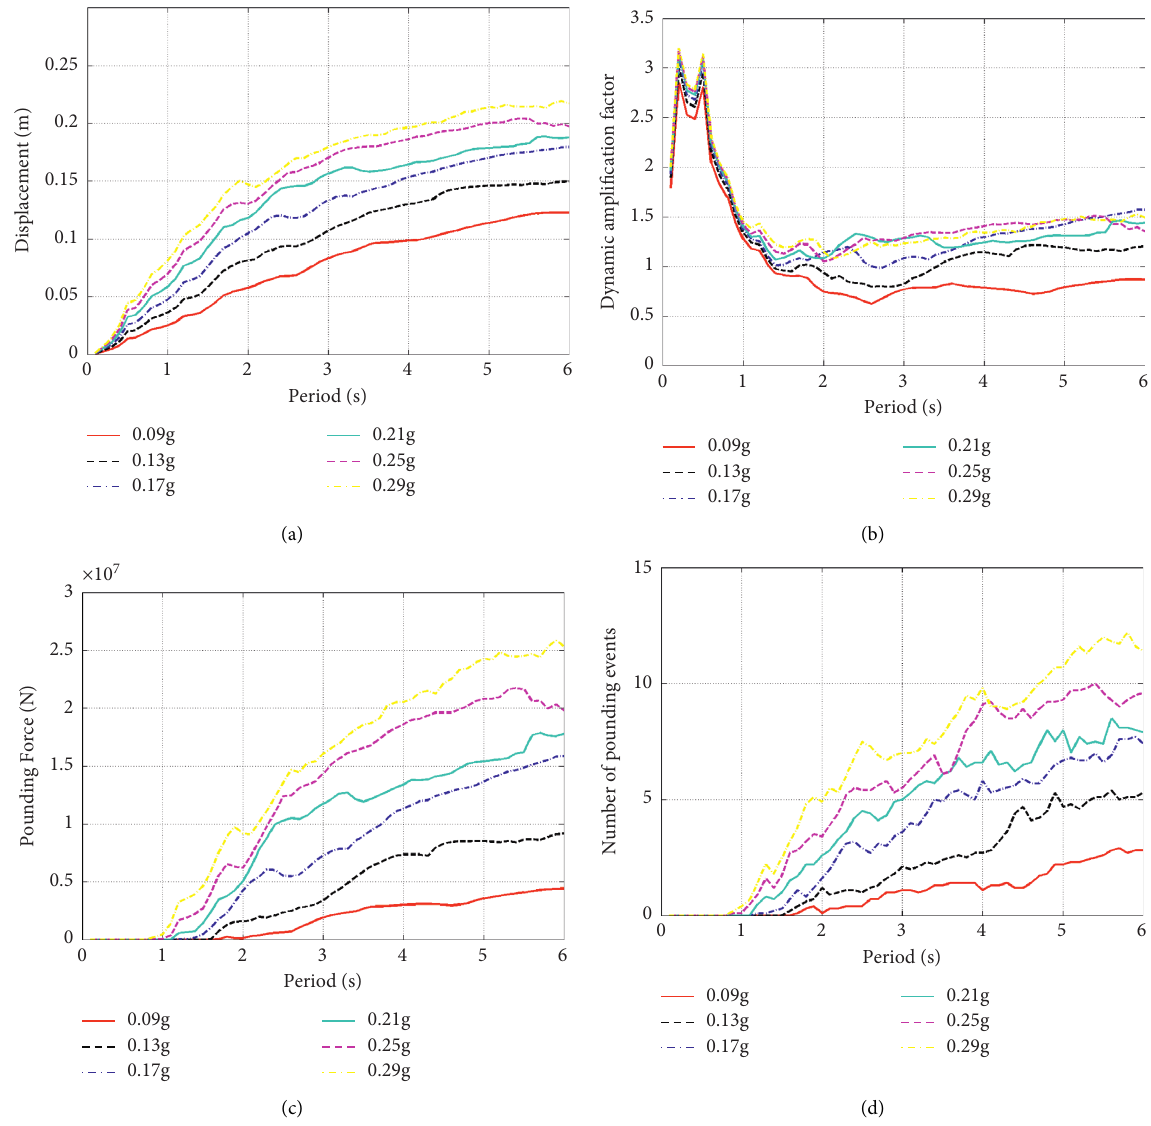
Figure 15: Average spectral analysis results using different PGA parameters. (a) Displacement spectrum. (b) Dynamic amplification factor spectrum. (c) Pounding force spectrum. (d) Number of pounding event response